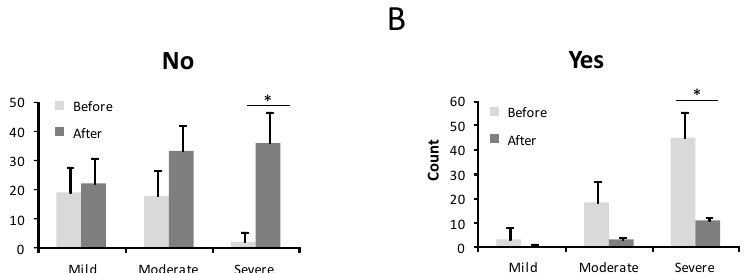
Figure 4. Number of patients who needed medical care before and after the treatment in mild, moderate, and severe HHT-ESS patients. ( A ). No need medical care. ( B ). Need medical care. * p < 0.05.